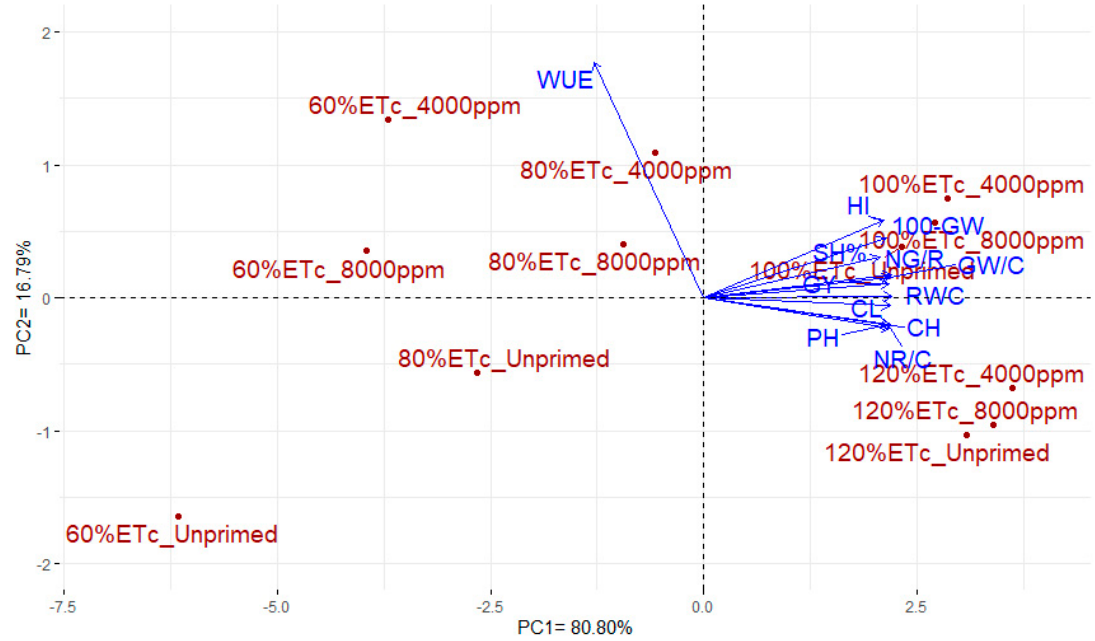
Figure 5. PCA biplot for the evaluated traits of maize under four irrigation regimes and two halo-priming treatments over two seasons 2018 and 2019. RWC: relative water content, CH: cob height, PH: plant height, CL: cob length, NG/R: number of grains row − 1 , NRC: number of rows cob − 1 , GW/C: grain weight cob − 1 , 100-GW: 100-grain weight, SH%: shelling percentage, GY: grain yield, WUE: water use efficiency, and HI: harvest index.